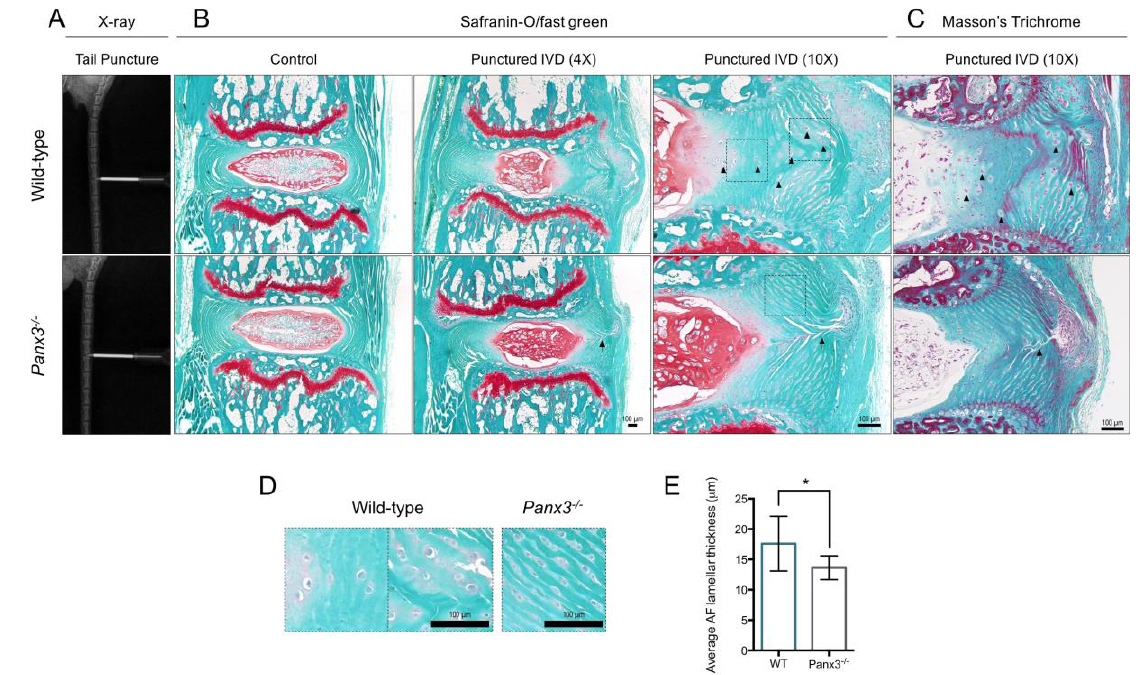
Int. J. Mol. Sci. 2021 , 21 , x FOR PEER REVIEW Figure 5. Panx3 -/- mice maintain AF tissue architecture following NP depressurization of caudal IVDs. ( A ) Representative X-ray images of WT and Panx3 -/- caudal IVDs undergoing needle puncture. ( B , C ) Representative mid-sagittal sections of caudal IVDs 7/8 and 8/9 from WT and Panx3 -/- mice harvested 6-weeks following needle puncture stained with ( B ) safranin-O/fast green and ( C ) Masson’s Trichrome. Adjacent, uninjured caudal IVD 6/7 served as the control. Images representative of n = 6 mice per group, 2 IVDs per mouse. Arrowheads indicate enlarged AF cells detected in WT mice following injury, arrows mark the needle puncture track. ( D ) Magnified view of AF cells in WT and Panx3 -/- caudal IVDs 6-weeks following needle puncture. Images correspond to areas indicated by boxes in panel B. ( E ) Average AF lamellar thickness in WT and Panx3 -/- IVDs following needle puncture injury. Lamellar thickness (inclusive of lamellar and inter-lamellar widths) was measured throughout the AF of Mason’s Trichrome stained caudal IVDs post-puncture and averaged per IVD. (* indicates, p < 0.05, unpaired t-test; n = 6 mice per group, 2 IVDs per mouse).